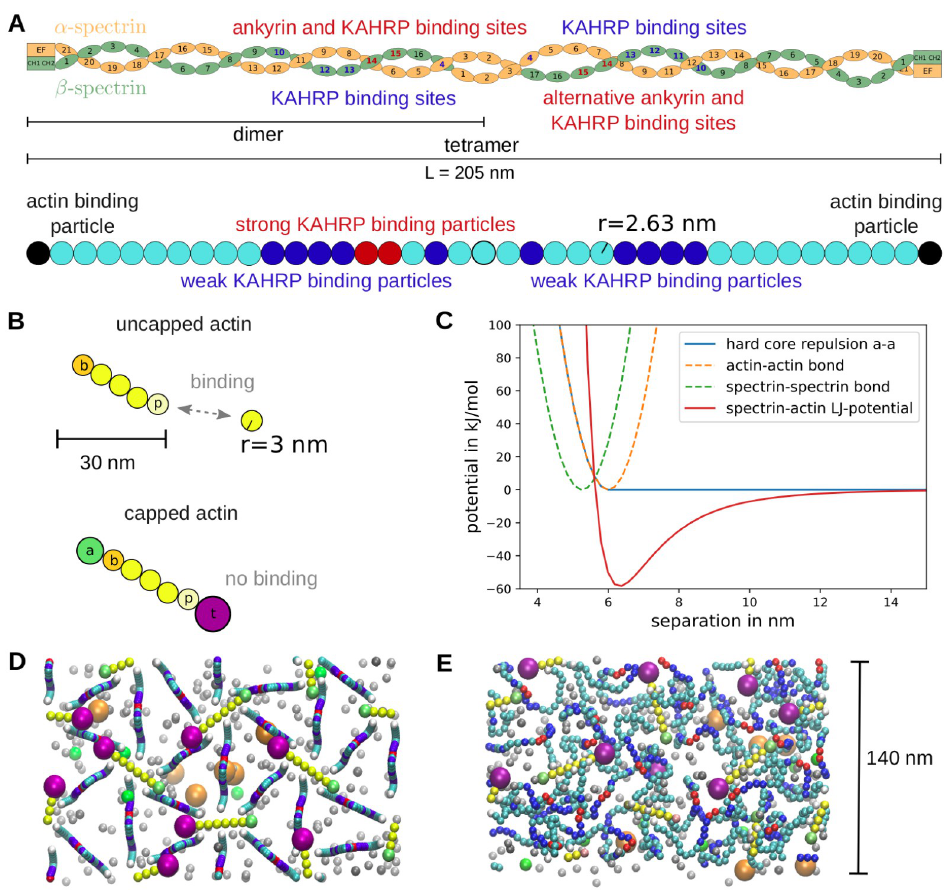
Fig 2. Particle-based model for the RBC cytoskeleton. (A) Schematic of the spectrin tetramer structure at the top and implementation in the simulation at the bottom. Differently coloured beads have different properties that represent the interactions of the spectrin filaments with actin, ankyrin and KAHRP. (B) Implementation of dynamic actin filaments in the simulations. The top filament can polymerize at both ends with different rates at the barbed ( b ) and pointed ( p ) ends. For the filament at the bottom the polymerization is blocked, since the capping proteins adducin ( a ) and tropomodulin ( t ) are attached. (C) The potentials used in the simulations are plotted against particle separation. (D) The initial configuration of a typical simulation is shown as a projection along the z-direction. The simulation box has periodic boundaries and a size of 140 × 242.48 × 100 nm − 3 . G-actin particles are shown in grey. An example simulation can be seen in the S1 Movie. (E) Equilibrated state of the